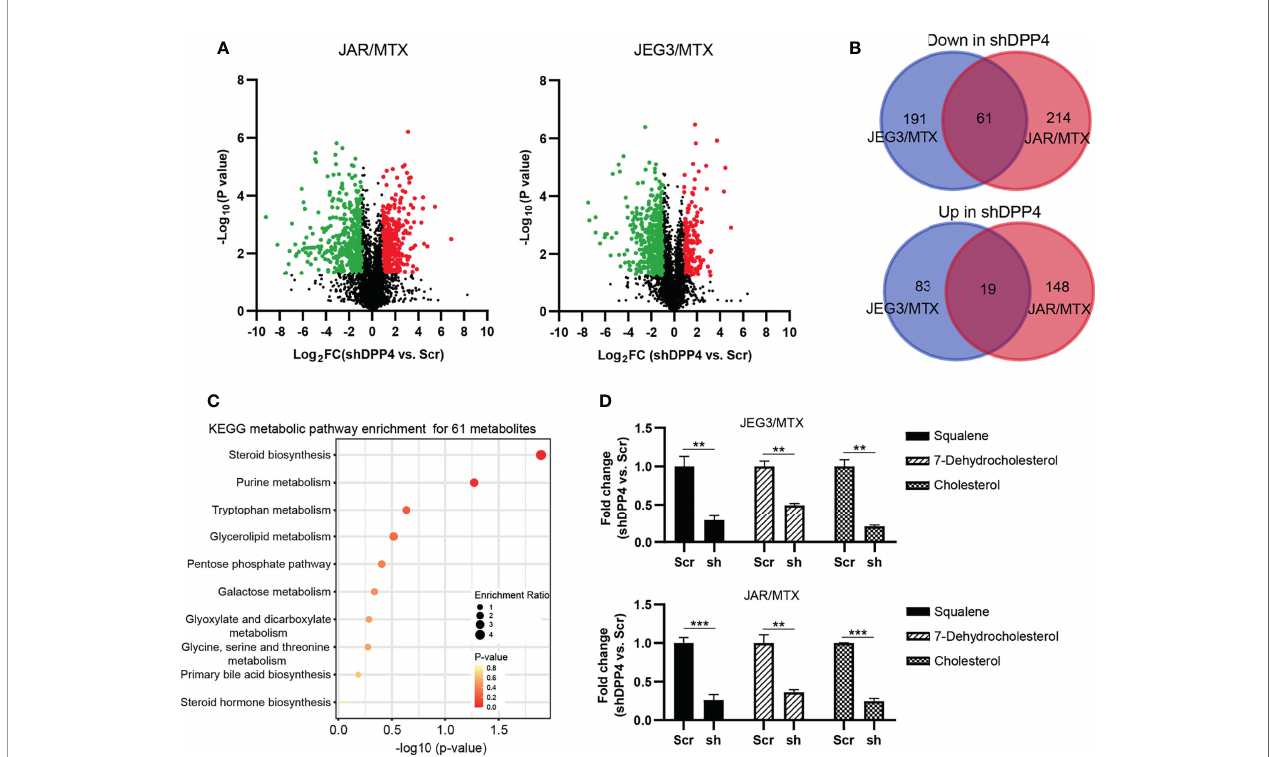
FIGURE 1 | DPP4 is a metabolic regulator of cholesterol biosynthesis in GTN cells. (A) Volcano plots showing the differential alteration of metabolites associated with DPP4 knockdown in MTX-resistant GTN sublines. (B) Venn diagram of up- or down-regulated metabolites associated with DPP4 knockdown across MTX- resistant GTN sublines. (C) KEGG analysis on 61 metabolites was conducted to show the enrichment of metabolic pathways. The top 10 pathways that arise with low p-values and with high enrichment ratio are indicated in the fi gure. (D) Metabolites involved in steroid biosynthesis were greatly impacted by DPP4 knockdown. n=3, **P<0.01;